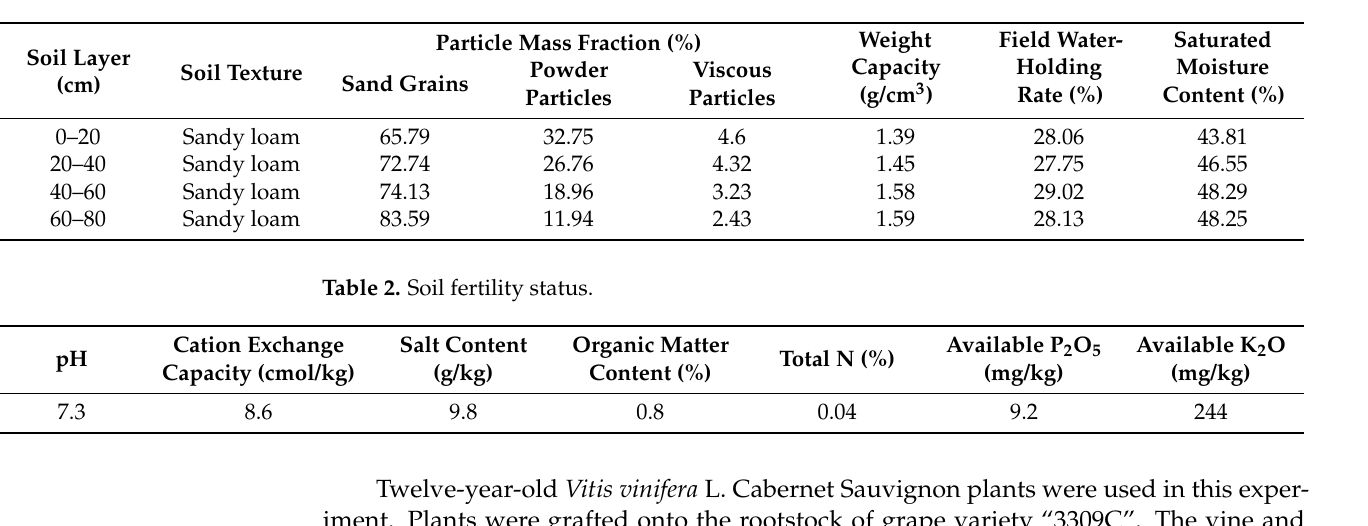
Table 1. Main physical properties of the soil.